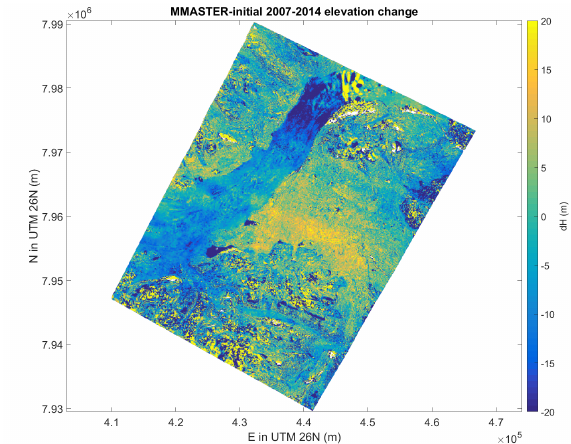
Figure 5: Example of measured elevation change from two ASTER DEMs after co-registration. For an overview of the area covered see Figure